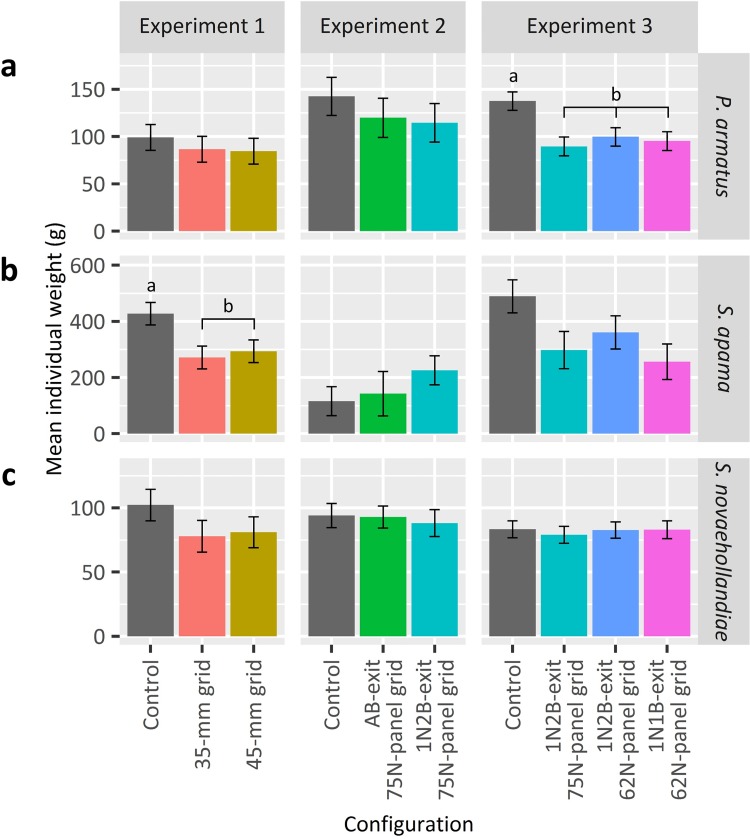
Predicted mean individual weights (± SE) of (a) Portunus armatus, (b) Sepia apama and (c) S. novaehollandiae by configuration and experiment. Where there was a significant configuration effect (p < 0.05) among a species within an experiment, letters above bars denote the false-discovery-rate (FDR) adjusted pairwise comparisons (p < 0.05).